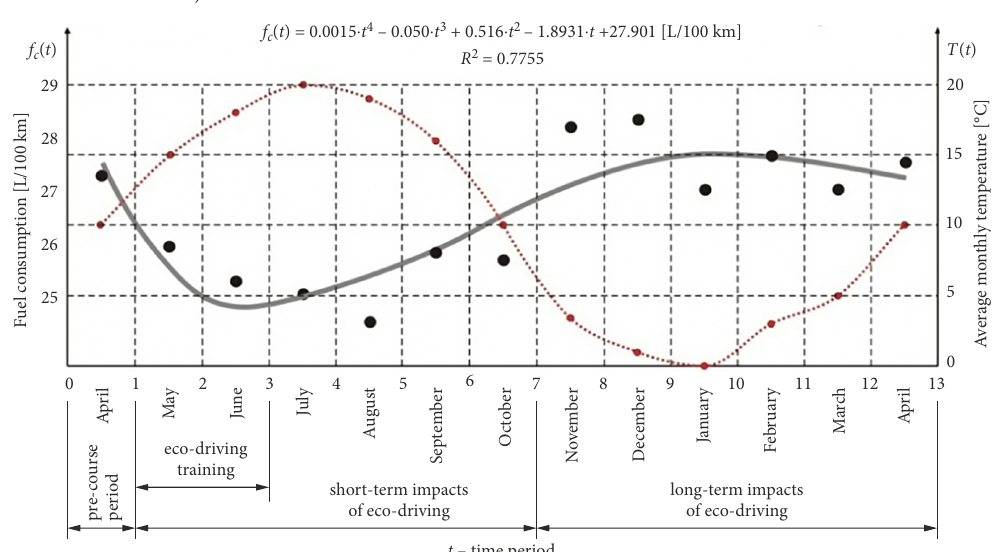
Figure 6. Distribution of FC (correlation function) and average monthly